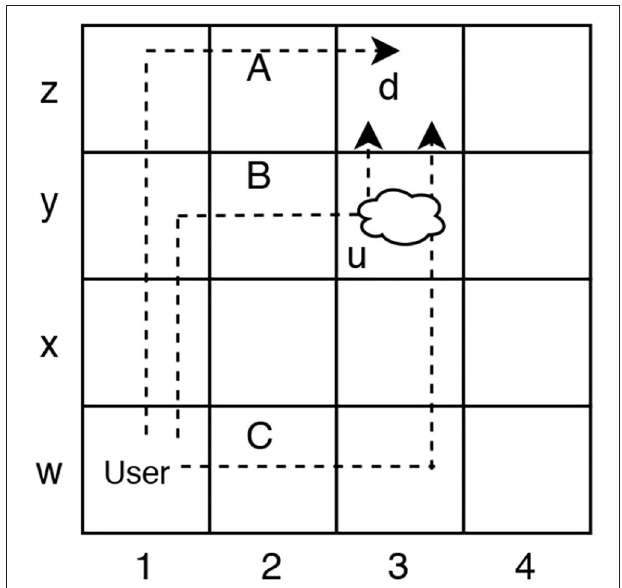
FIGURE 1 | In this Grid Navigation domain, a rational user who is unaware of u, may choose to execute plans A, B, or C because they are of equal (optimal) cost. Observer must recognize that intervention is required if the user is executing plans B or C before u is satisfied.